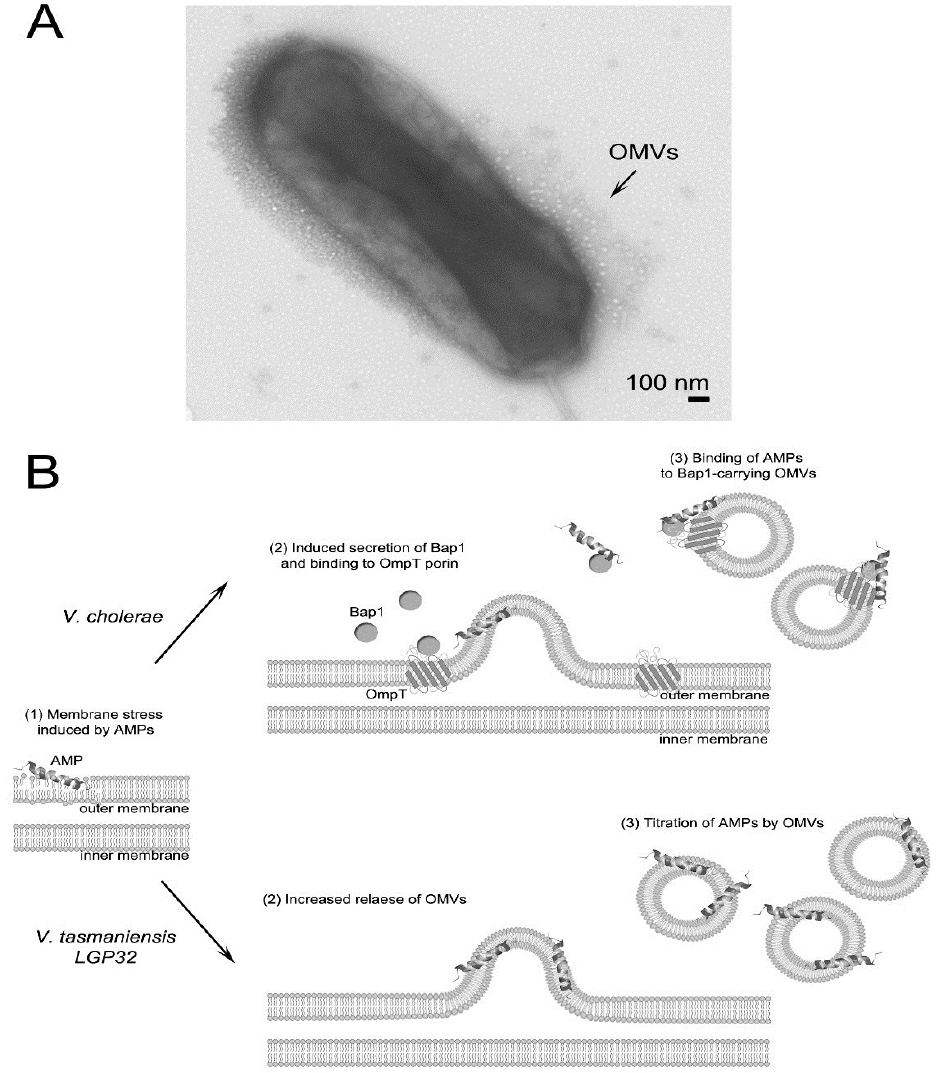
Figure 2. Model for AMP-titration by outer membrane vesicles (OMVs) in V. cholerae and V. tasmaniensis . ( A ) OMVs released in the extracellular medium by the hypervesiculating  ompU mutant of V. tasmaniensis strain LGP32. Logarithmic phase cultures were negatively stained and observed by transmission electron microscopy as described in [120]; ( B) The role of OMVs in the protection against AMPs has been recently described in two species of vibrios. In V. cholerae , OMVs cross-protect against the human cathelicidin LL-37 when bacteria are exposed to sublethal concentrations of PmB. Those OMVs are associated with Bap1 protein which serves as a ligand for LL-37. The association of Bap1 to OMVs is mediated by the outer membrane protein, OmpT [119]. In V. tasmaniensis , OMVs produced in the absence of AMPs are sufficient to titrate PmB and confer a potent dose-dependent protection against PmB. Although the molecular basis of PmB binding to V. tasmaniensis OMVs remain unknown, it is speculated that titration may occur by PmB insertion in the OMV membranes. The release of OMVs was shown to be strongly enhanced by the contact of V. tasmaniensis with oyster plasma [120]. In both species, OMV release is thought to create a protective membranous shield that prevents the interaction of membrane-active AMPs with the bacterial